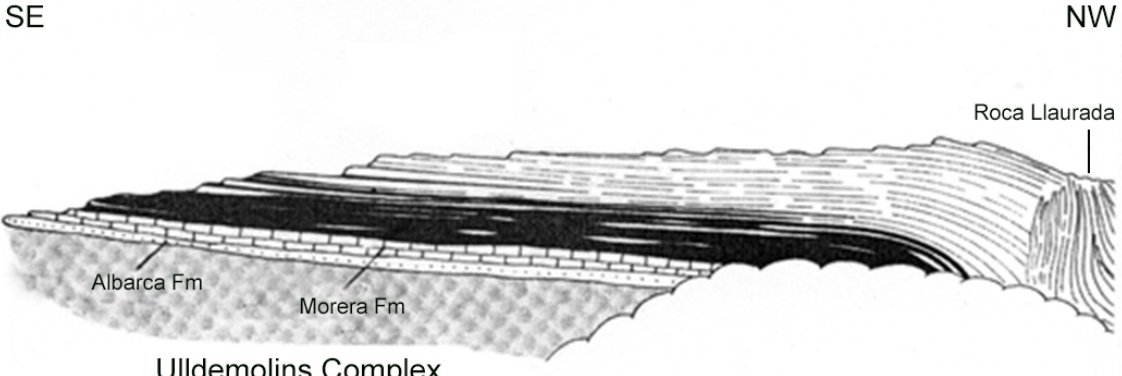
Figure 4. Scheme showing the layout of the levels of Montsant Massif levels and Roca Llaurada downdip. (Modified from Colombo & Vergés